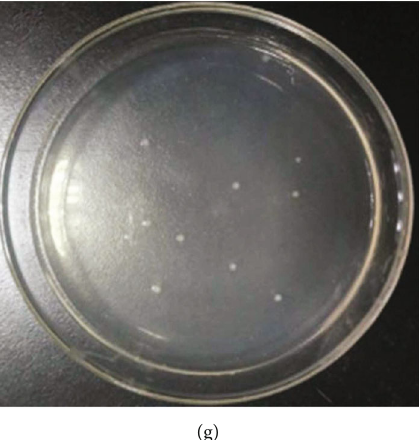
Figure 10: Antibiosis performances of membrane. (a) PAN substrate membrane, (b) NF-Ag-0, (c) NF-Ag-1, (d) NF-Ag-2, (e) NF-Ag-3, (f) NF-Ag-4, and (g)